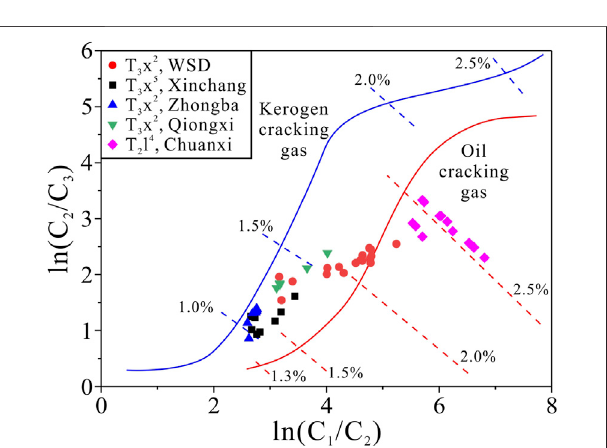
FIGURE 6 | Correlation diagram between δ D 1 and δ 13 C 2 values of the T 3 x 2 gas from the Western Sichuan Depression (modi fi ed after Wang et al., 2015).